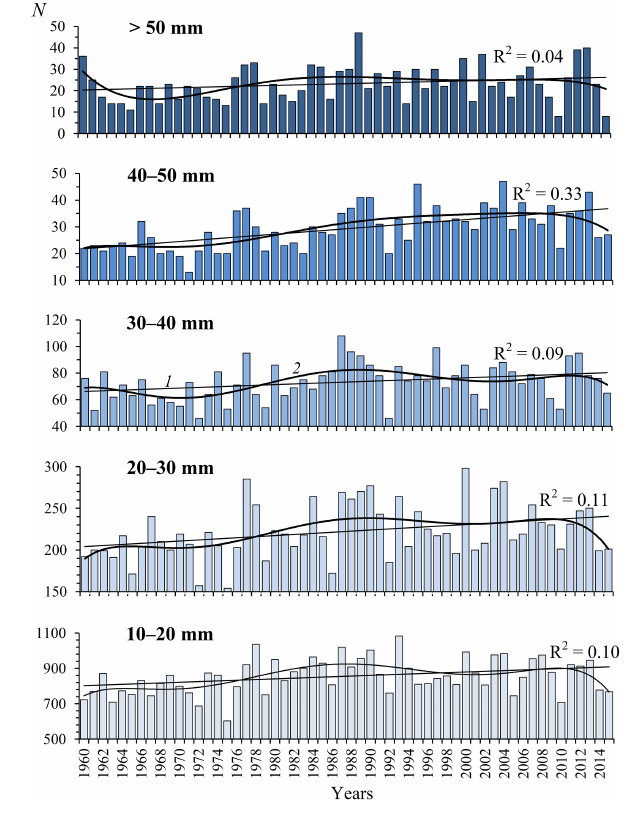
Figure 1. The mean annual number of days ( N , units) with different amounts of daily precipitation (warm season, May–September) for the period 1960–2015 for all 176 meteorological stations on the RP used in this analysis. 1 – linear trend, 2 – sixth-degree polynomial trend.